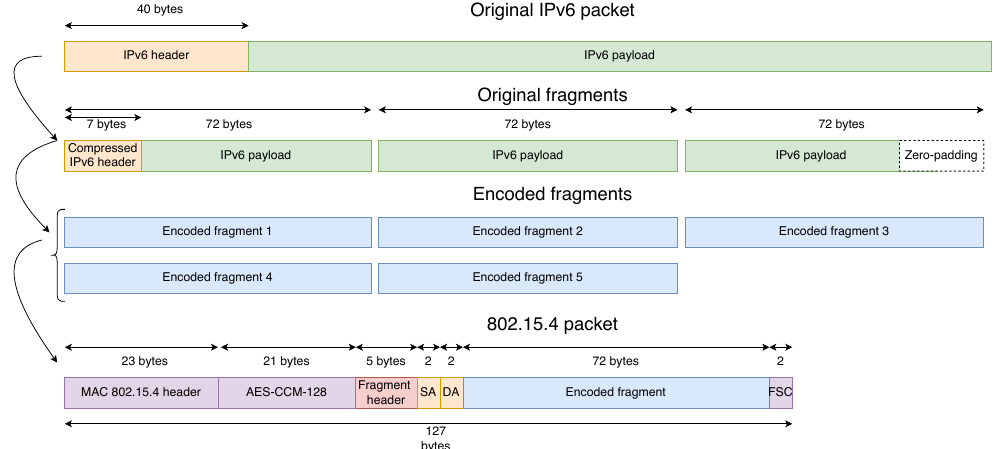
Figure 12. Structure of the MAC frame with NCFEC. SA and DA stand for Source Address and Destination Address of the IPv6